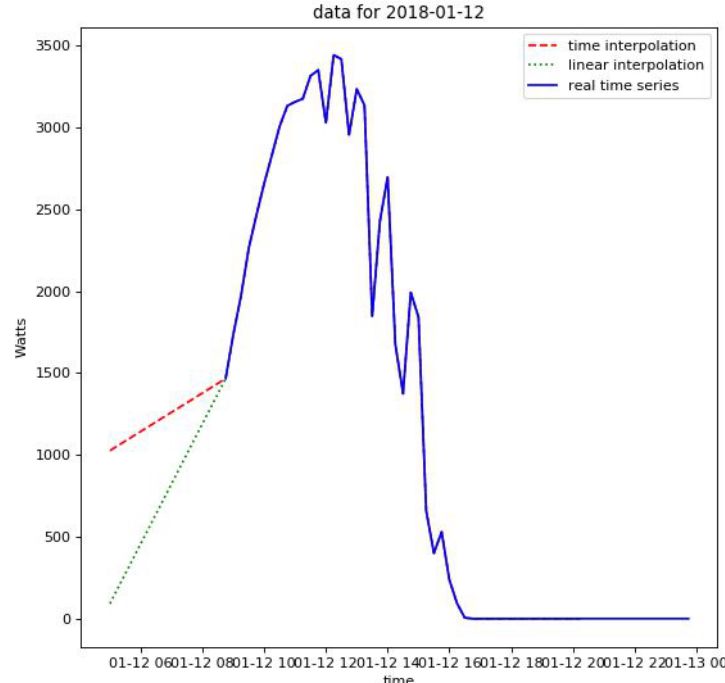
Figure 2. Linear vs. time interpolation methods on a single, incomplete day of PV